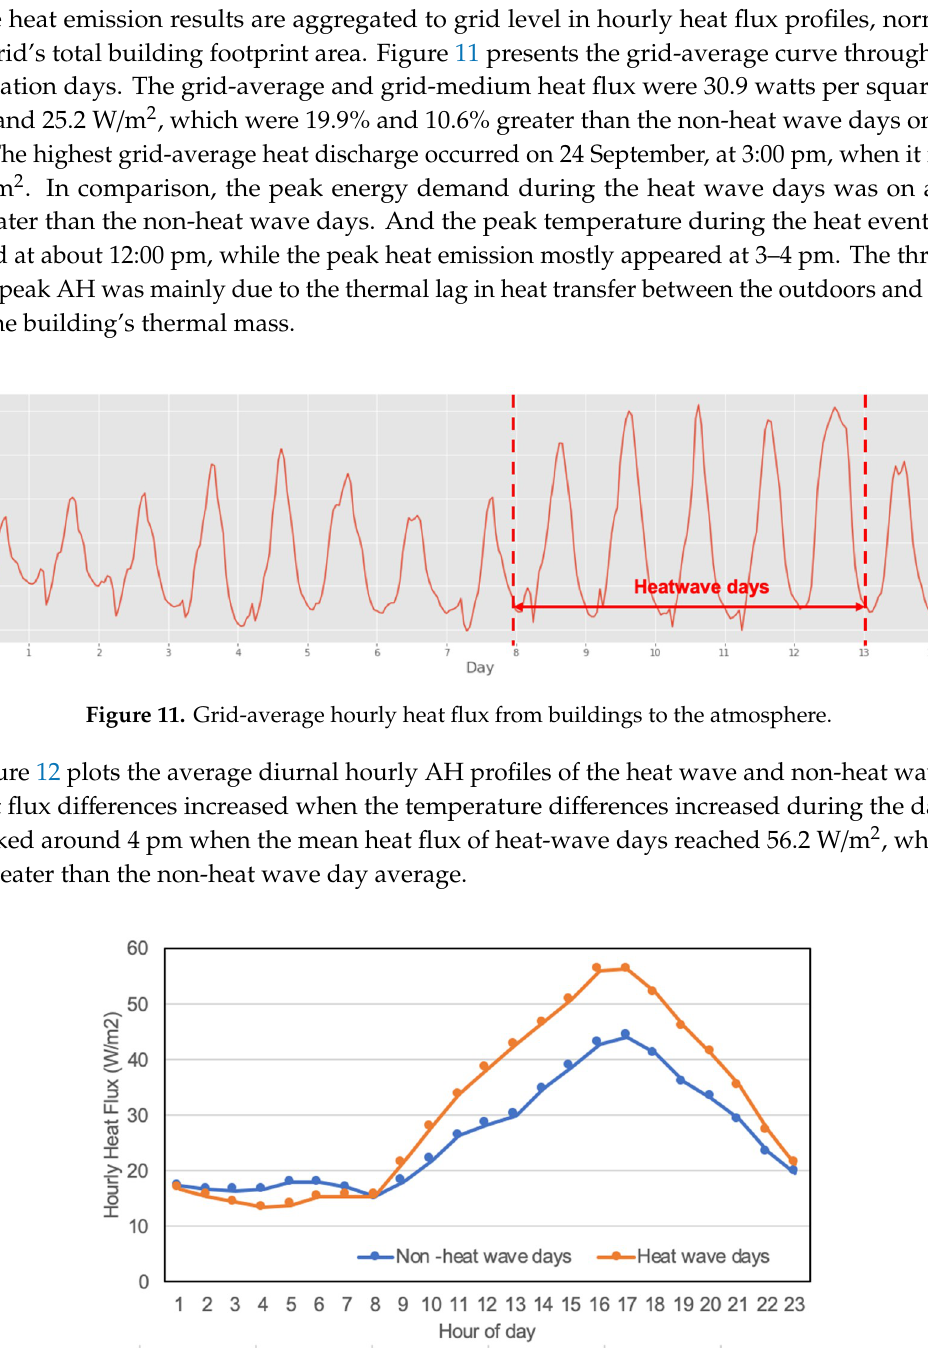
Figure 10. Wind speed (m/s) distribution during the heat wave. ( a ): Temporal variation (averaged over all grids), ( b ) Spatial distribution.